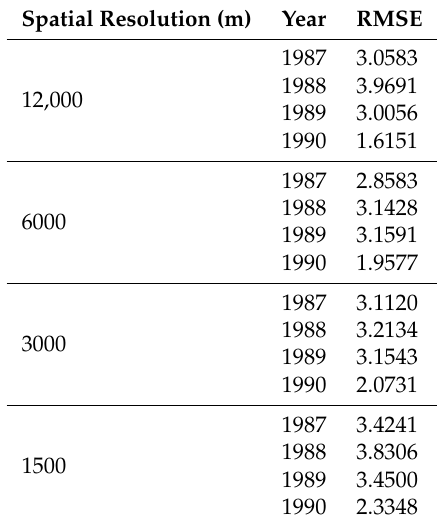
Table 3. Comparison of the RMSE in all four years and